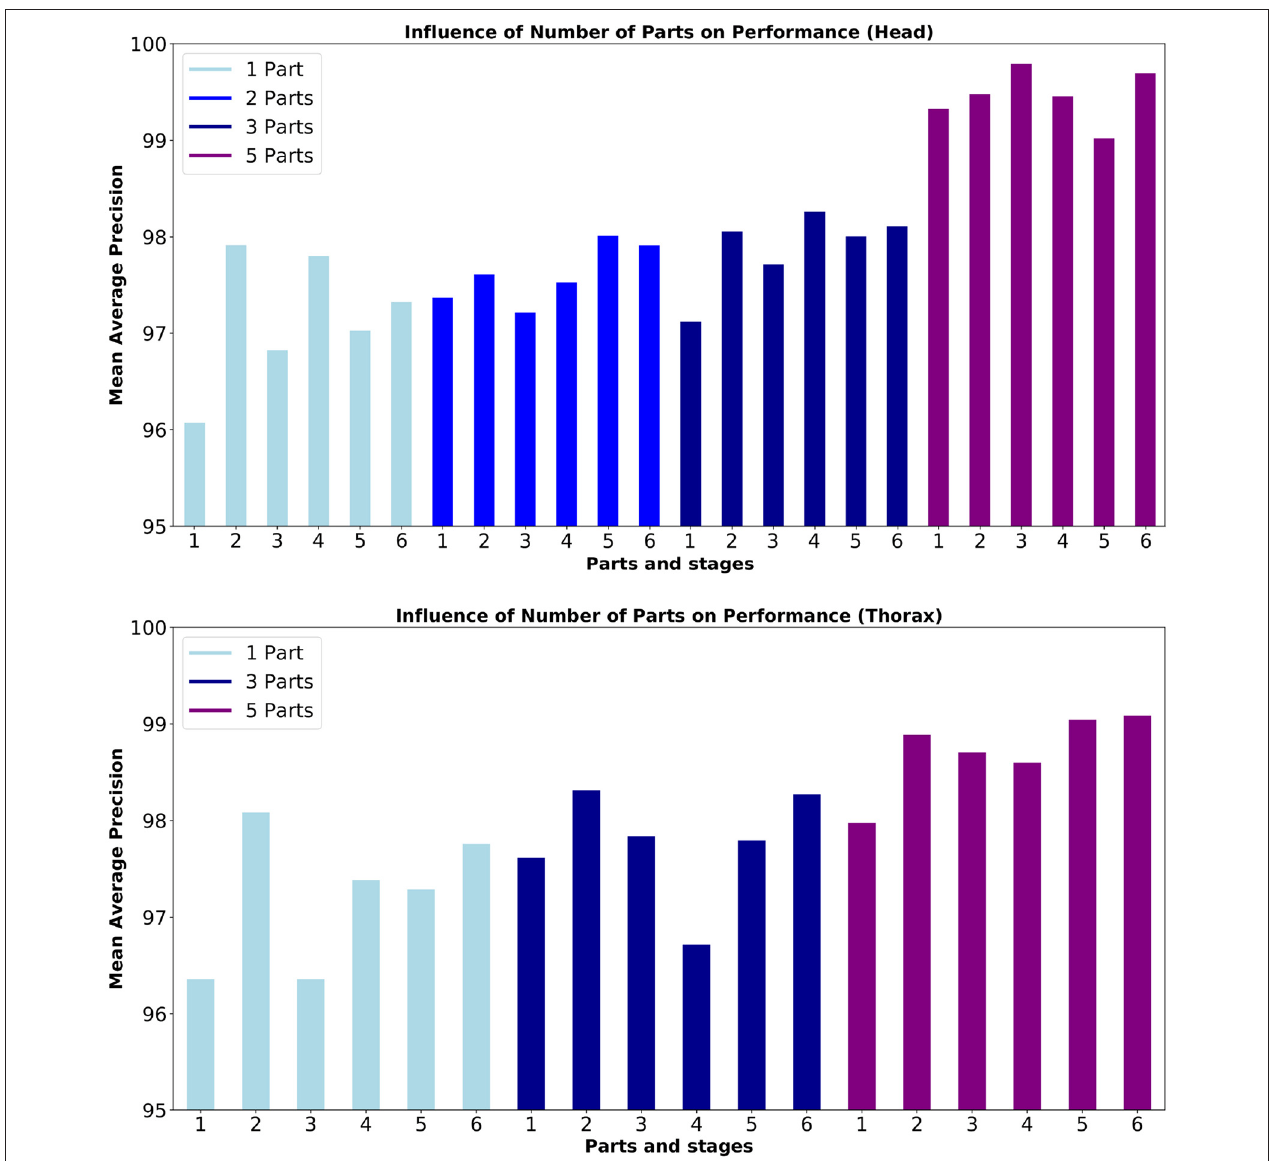
FIGURE 7 | Mean Average Precision (mAP) for the detection of (top) head and (bottom) thorax. The box plot shows performance mean 19,000 epochs of training. From left to right, results for Head show training using 1 part (Head), 2 parts (Head, Abdomen), 3 (Head, Abdomen, Thorax), and 5 parts (3 parts + 2 antennas) results for Thorax show training using 1 part (Thorax), 3 parts (Head, Abdomen, Thorax), and 5 parts (3 parts + 2 antennas). Description of the mAP can be found in Section